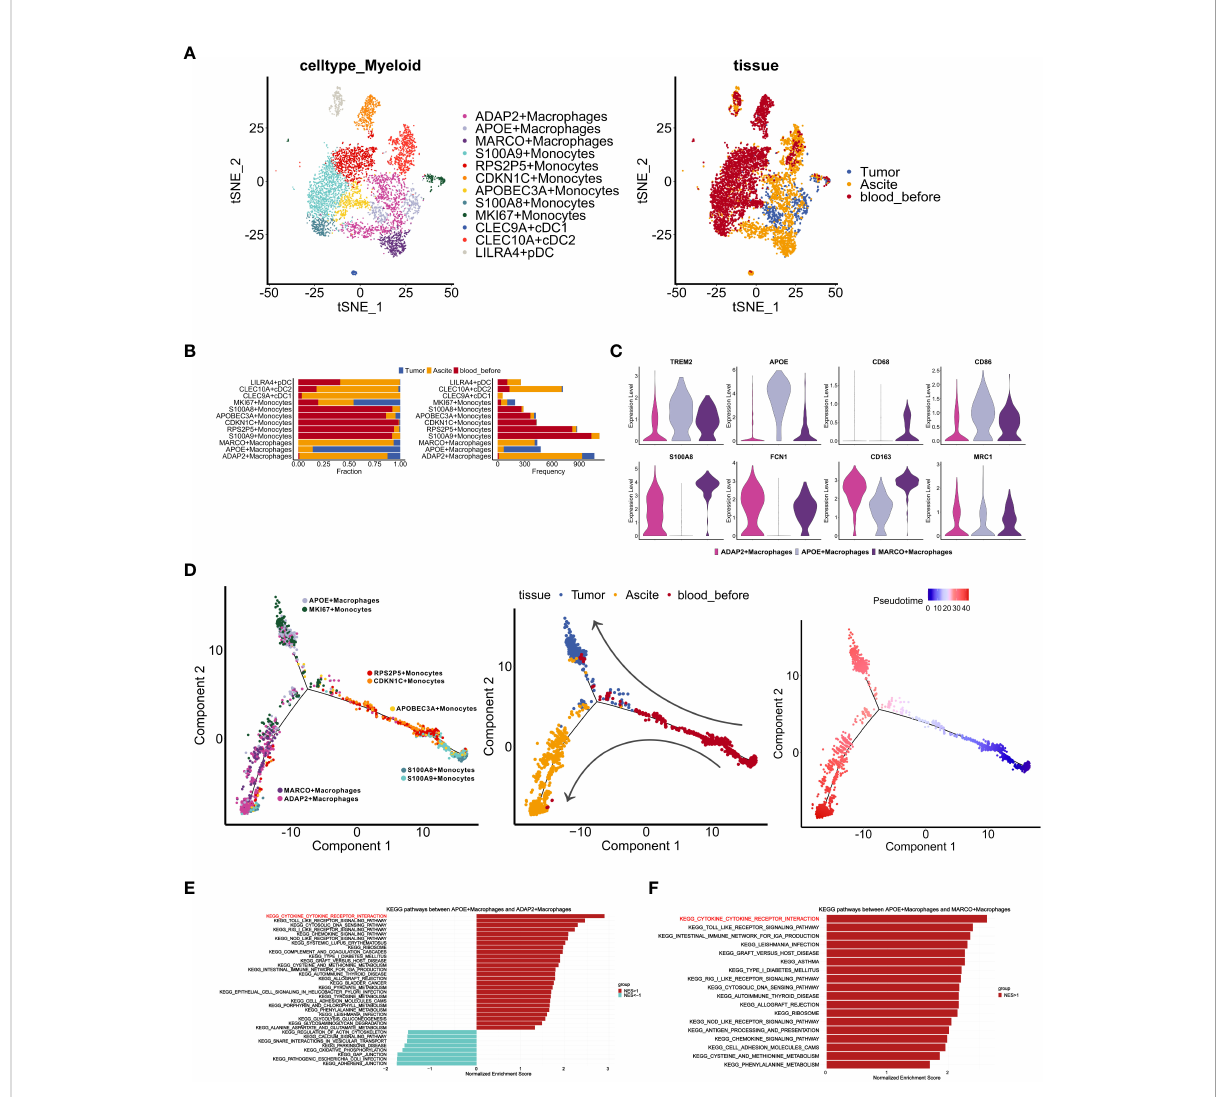
FIGURE 3 Characteristics of myeloid cells in distinct TMEs of ascites, tumor and PBMCs. (A) t-SNE visualization of myeloid cells pro fi les from three samples ( Tumor, Asicite, blood_before ) before the fourth course of chemotherapy, colored by myeloid cell subclusters (left panel) and sample origins (right panel). (B) Fraction and frequency of myeloid cells (x axis) from samples ( Tumor, Asicite, blood_before ) in each myeloid subcluster (y axis). (C) Violin plots display the expression TAM- ( TREM2, APOE ), MDSC- ( S100A8, FCN1 ) and M1-like ( CD68, CD86 ), M2-like ( CD163, MRC1 ) signatures expression among three macrophage subclusters (ADAP2+ Macrophages, APOE+ Macrophages, MARCO+ Macrophages). (D) Pseudotime analysis of monocytes and macrophages from samples ( Tumor, Asicite, blood_before ), colored by each myeloid subcluster (left panel), derived-samples (middle panel) and pseudotime trajectory (right panel). (E, F) Gene set enrichment analysis between APOE subcluster and ADAP2 subcluster (E) , APOE and MARCO subcluster (F) using KEGG gene sets. Pathway enrichment is expressed as normalized enrichment score